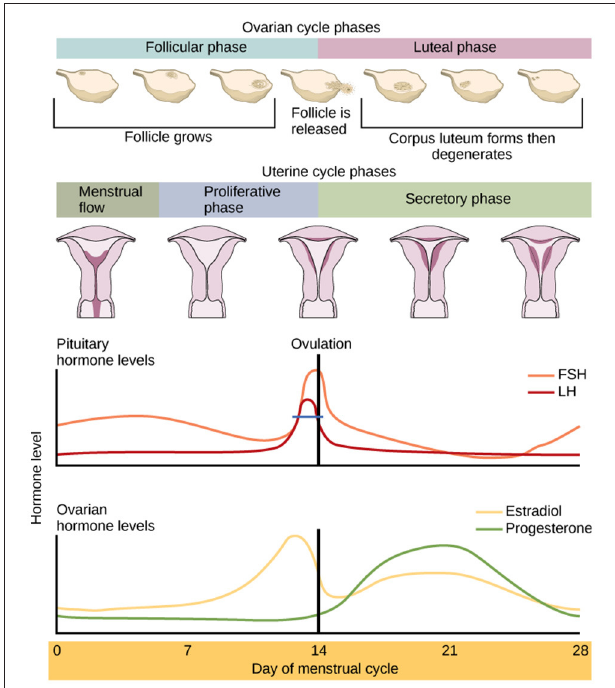
FIGURE 1 | The hormonal composition of the menstrual cycle and its phases. This includes, the egg cycle, LH, FSH, Oestrogen (Estradiol [E2]), Progesterone and the lining of the uterus (